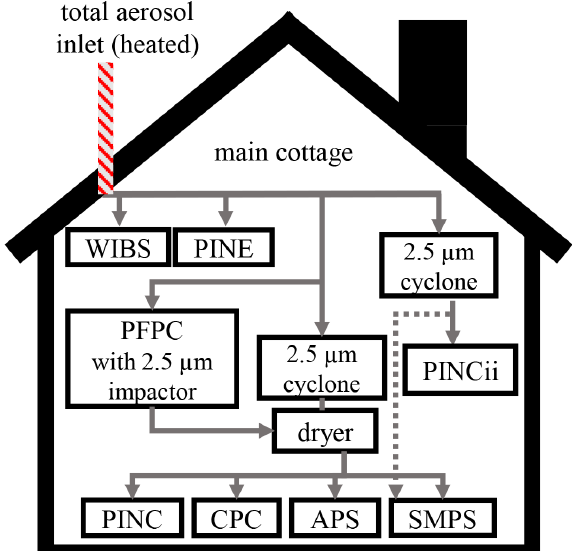
Figure 4. Instrumental setup in the main cottage. Note that PINC and its complete setup (PFPC, CPC, APS and SMPS) were used from 19 February to 2 April 2018 and were replaced by PINCii from 22 April to 10 June 2018. Between May 4 and May 23, the SMPS was used in parallel with PINCii, as represented with the dashed lines (see Sect. 2.2.1 for details).